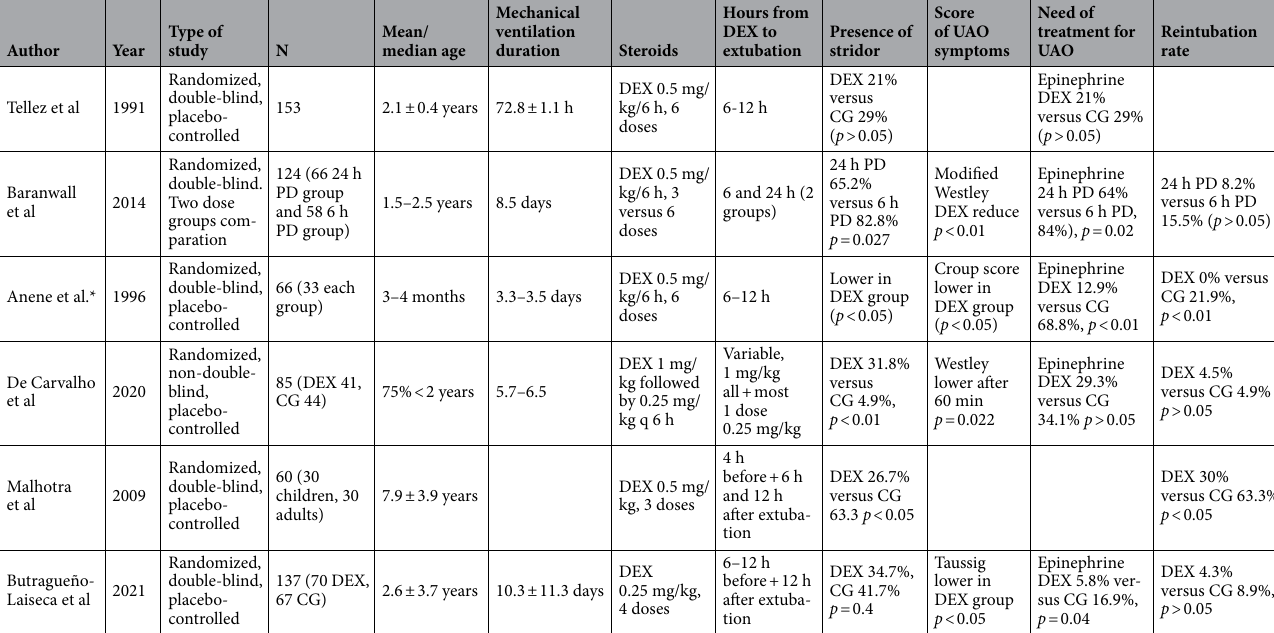
Table 5. Summary of prospective randomized studies with pediatric patients (not included studies with only neonatal patients). Acronyms: CG control group DEX dexamethasone. * This study includes patients with airway